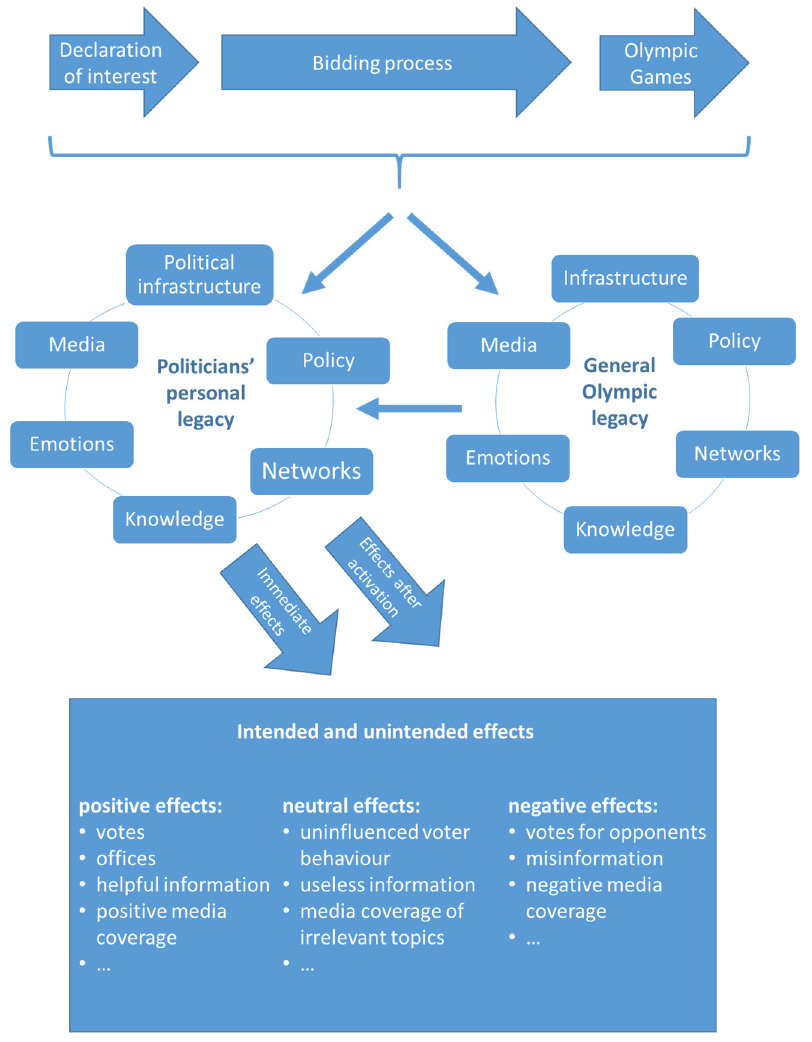
Figure 2. Sources and effects of politicians’ personal legacies from Olympic bidding processes and Games.